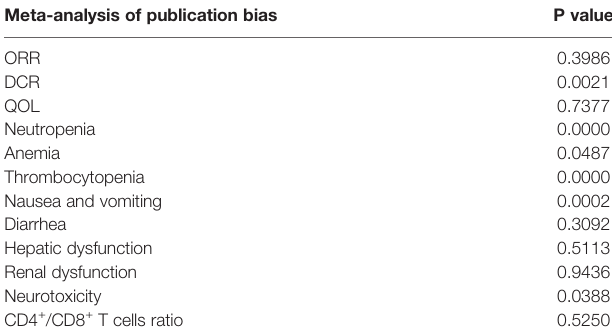
TABLE 5 | Egger ’ s test.